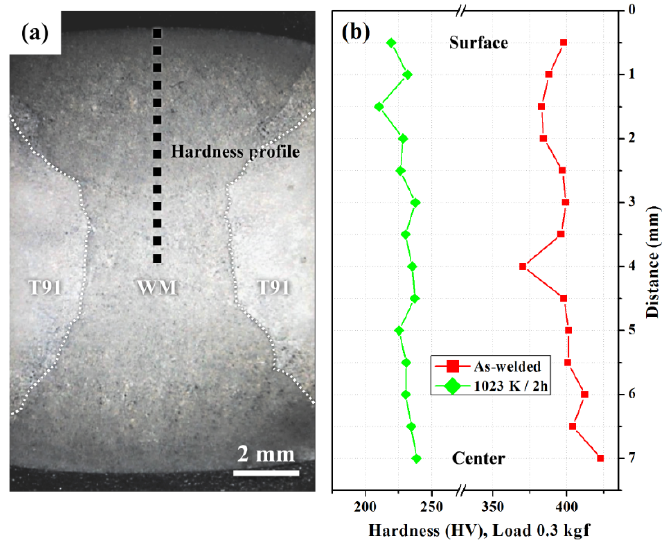
Figure 3. ( a ) The cross-sectional view of the butt-welded plate after multiple-pass welding and ( b ) the hardness distribution in the vertical direction from the weld surface to the center.